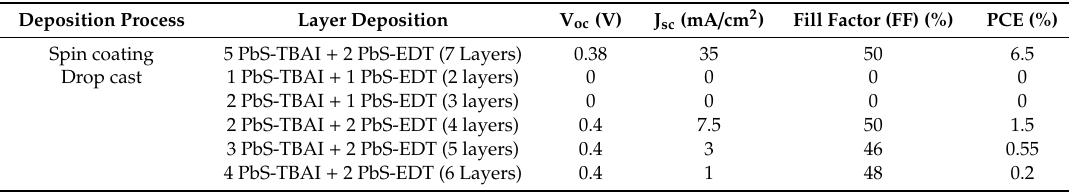
Table 1. Device parameters obtained from spin coating and drop cast